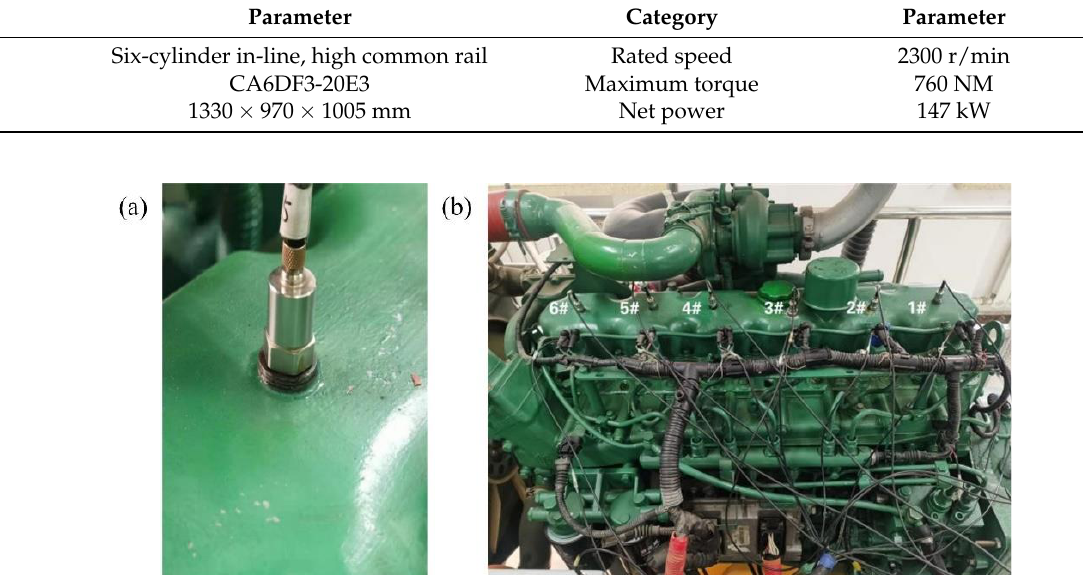
Figure 8. Vibration acceleration sensor and its installation location: ( a ) vibration acceleration sensor; ( b ) sensor installation location. ( b ) sensor installation